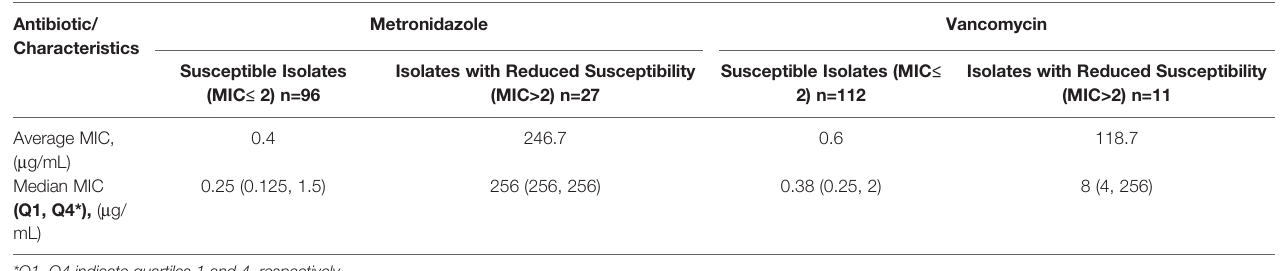
TABLE 1 | Antibiotic susceptibility pro fi les of study isolates. Antibiotic/ Characteristics